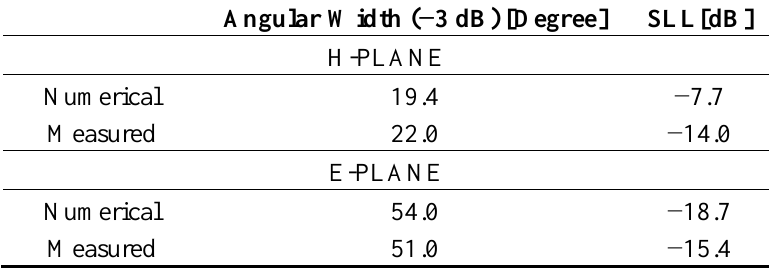
Table 4. Radiation parameters of receiving antenna: Comparison between calculated and measured